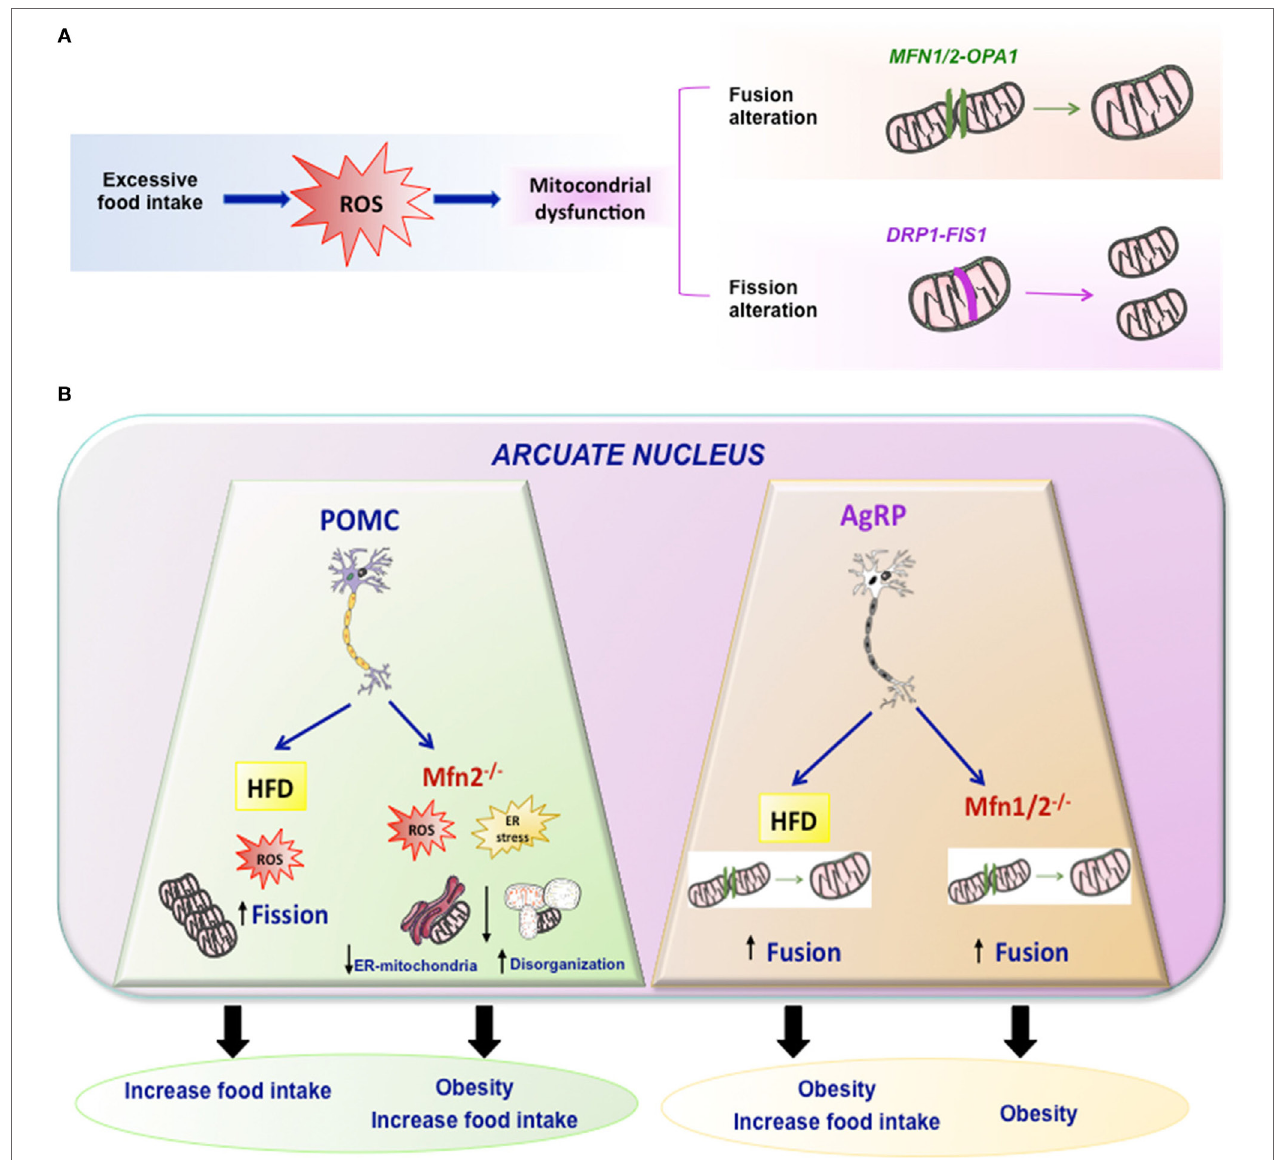
FigURe 2 | Mitochondrial dynamics. (A) Excessive food intake produce excess of ROS and mitochondrial dynamic dysfunction leading to altered fission or fusion. Fusion is driven by Mfn1 and Mfn2 localized on mitochondrial outer membranes, while OPA1 mediates mitochondrial inner membrane fusion. Mitochondrial fission is driven by DRP1 and it may involve FIS1. (B) Summary of the effects of HFD or mutations of Mfn2 or Mfn1/2 in specific arcuate neurons such POMC or AgRP in mitochondrial dynamic and energy